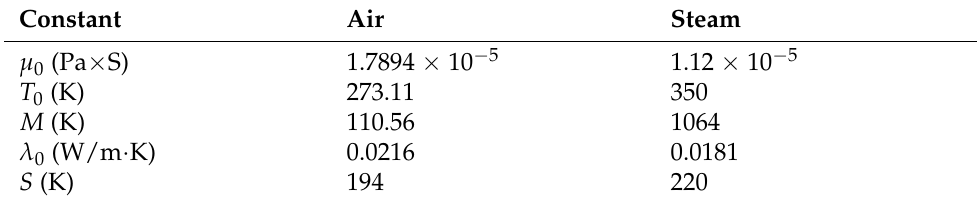
Table 5. Sutherland constants for air and steam [33].